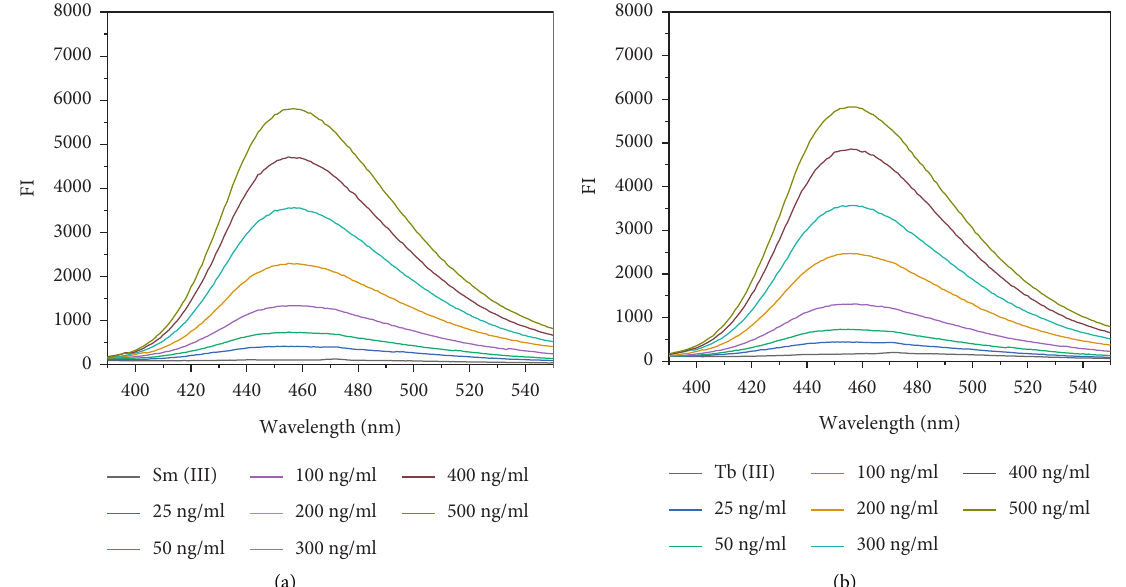
Figure 2: Fluorescence spectra for the interaction between Sm(III) (a) and Tb(III) (b) with different concentrations of ORLX from 25 to 500ng/mL.